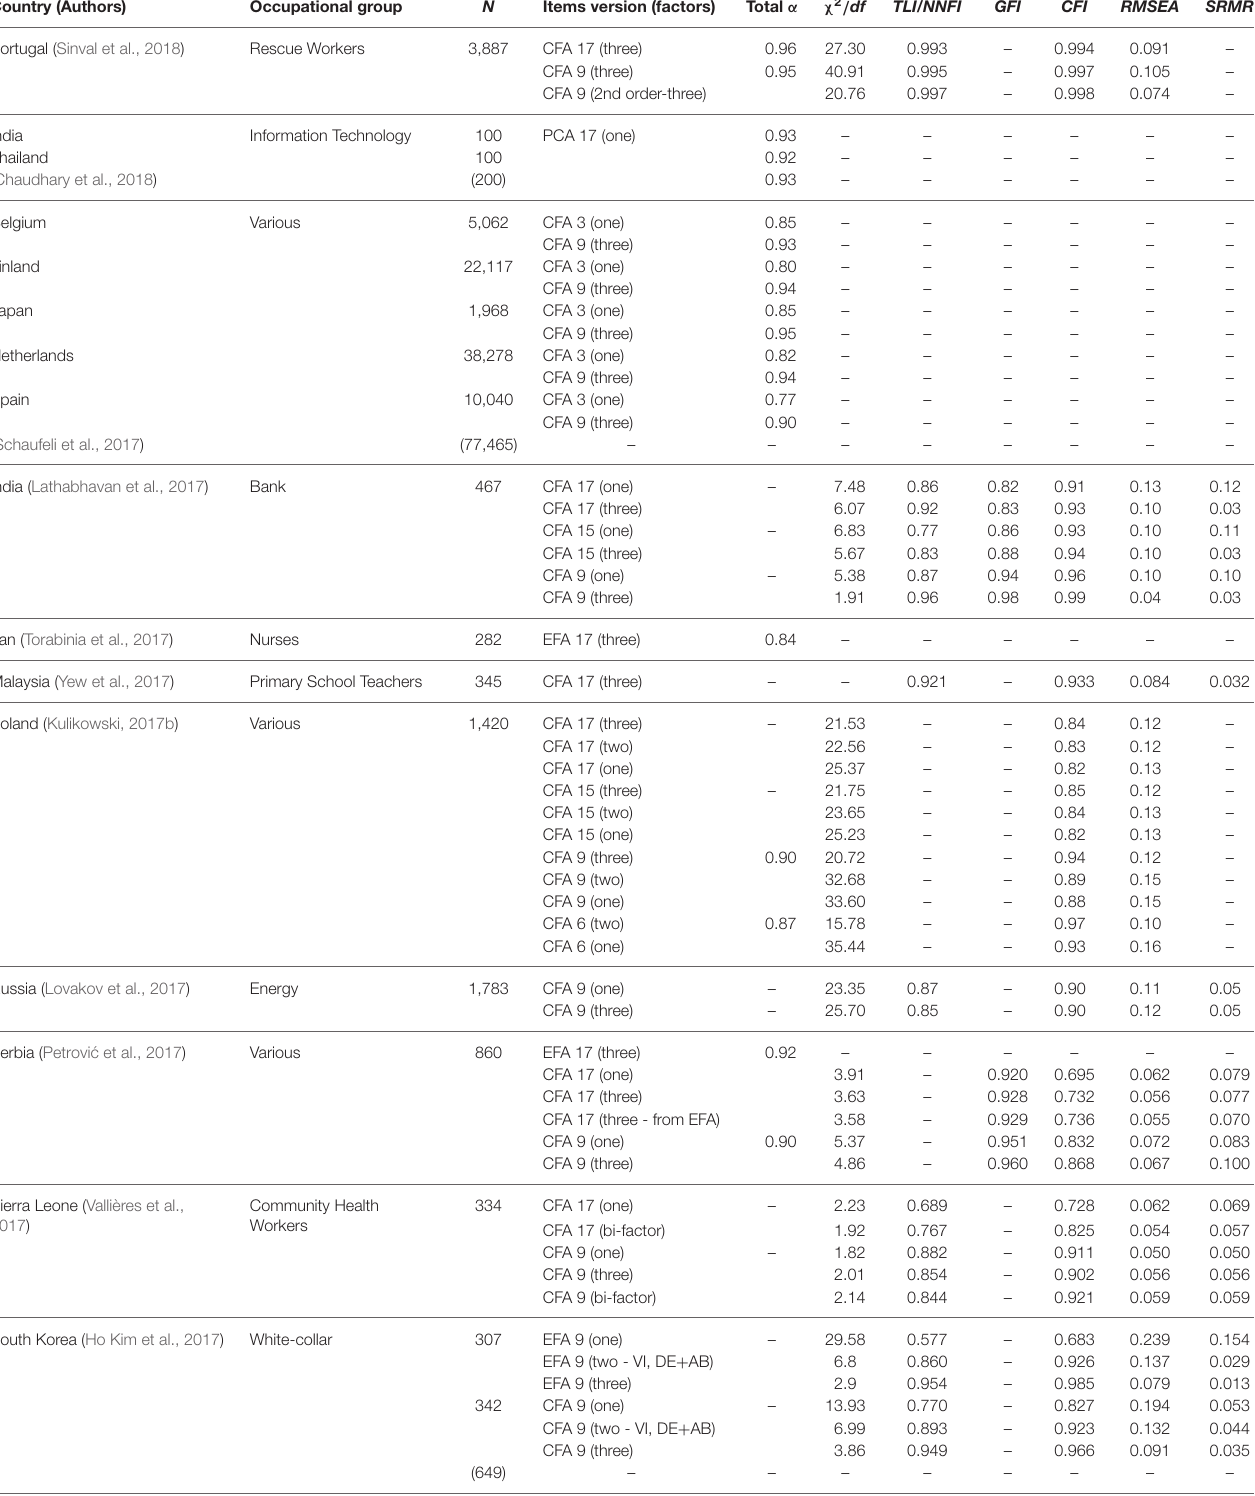
TABLE 1 | UWES versions and its Goodness-of-fit